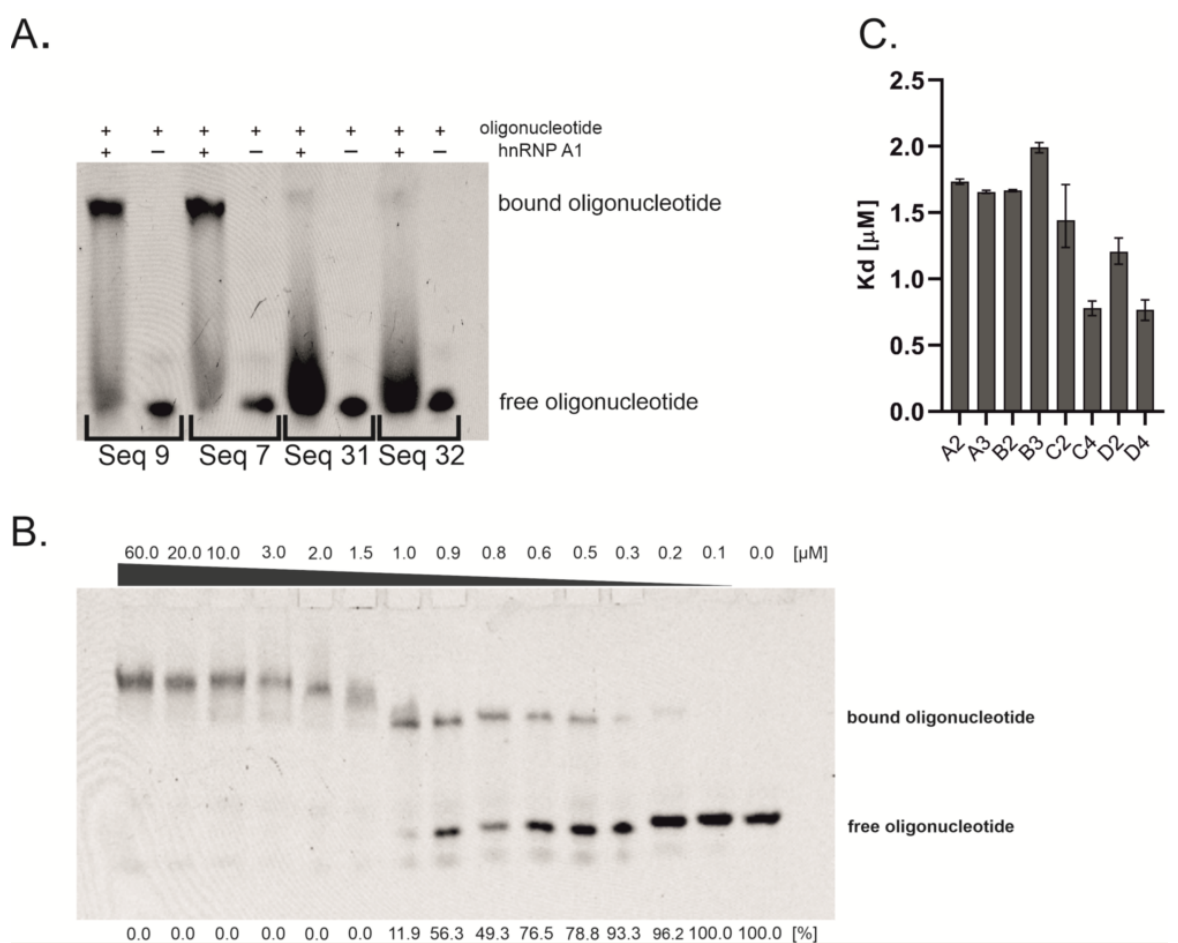
ent repetitions of regulatory sequences and determined their binding affinity to hnRNP A1 (Table 1). The 9-nt long sequences (A, B) were repeated two (A2, B2) and three times (A3, B3), whereas the 5-nt long sequences (C, D) were repeated two (C2, D2) and four times